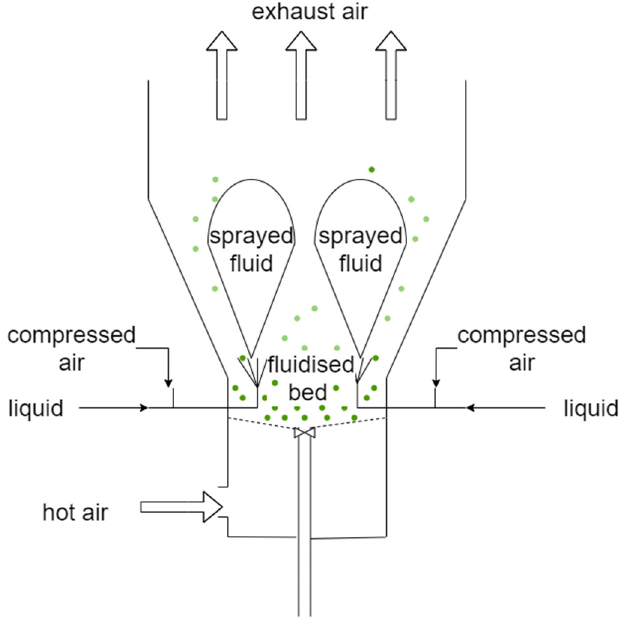
Figure 1. Scheme of the agglomeration process on the fluidized bed in the used apparatus.